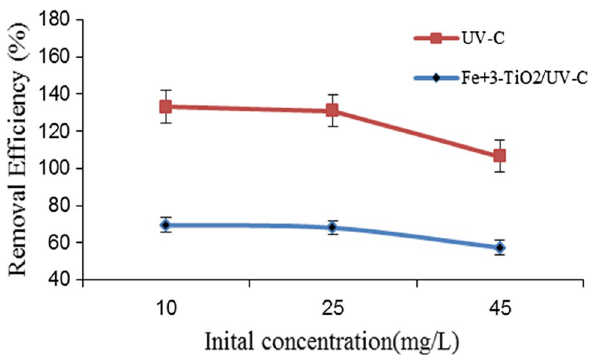
Fig. 10 t = 30 min, Fe +3 –TiO